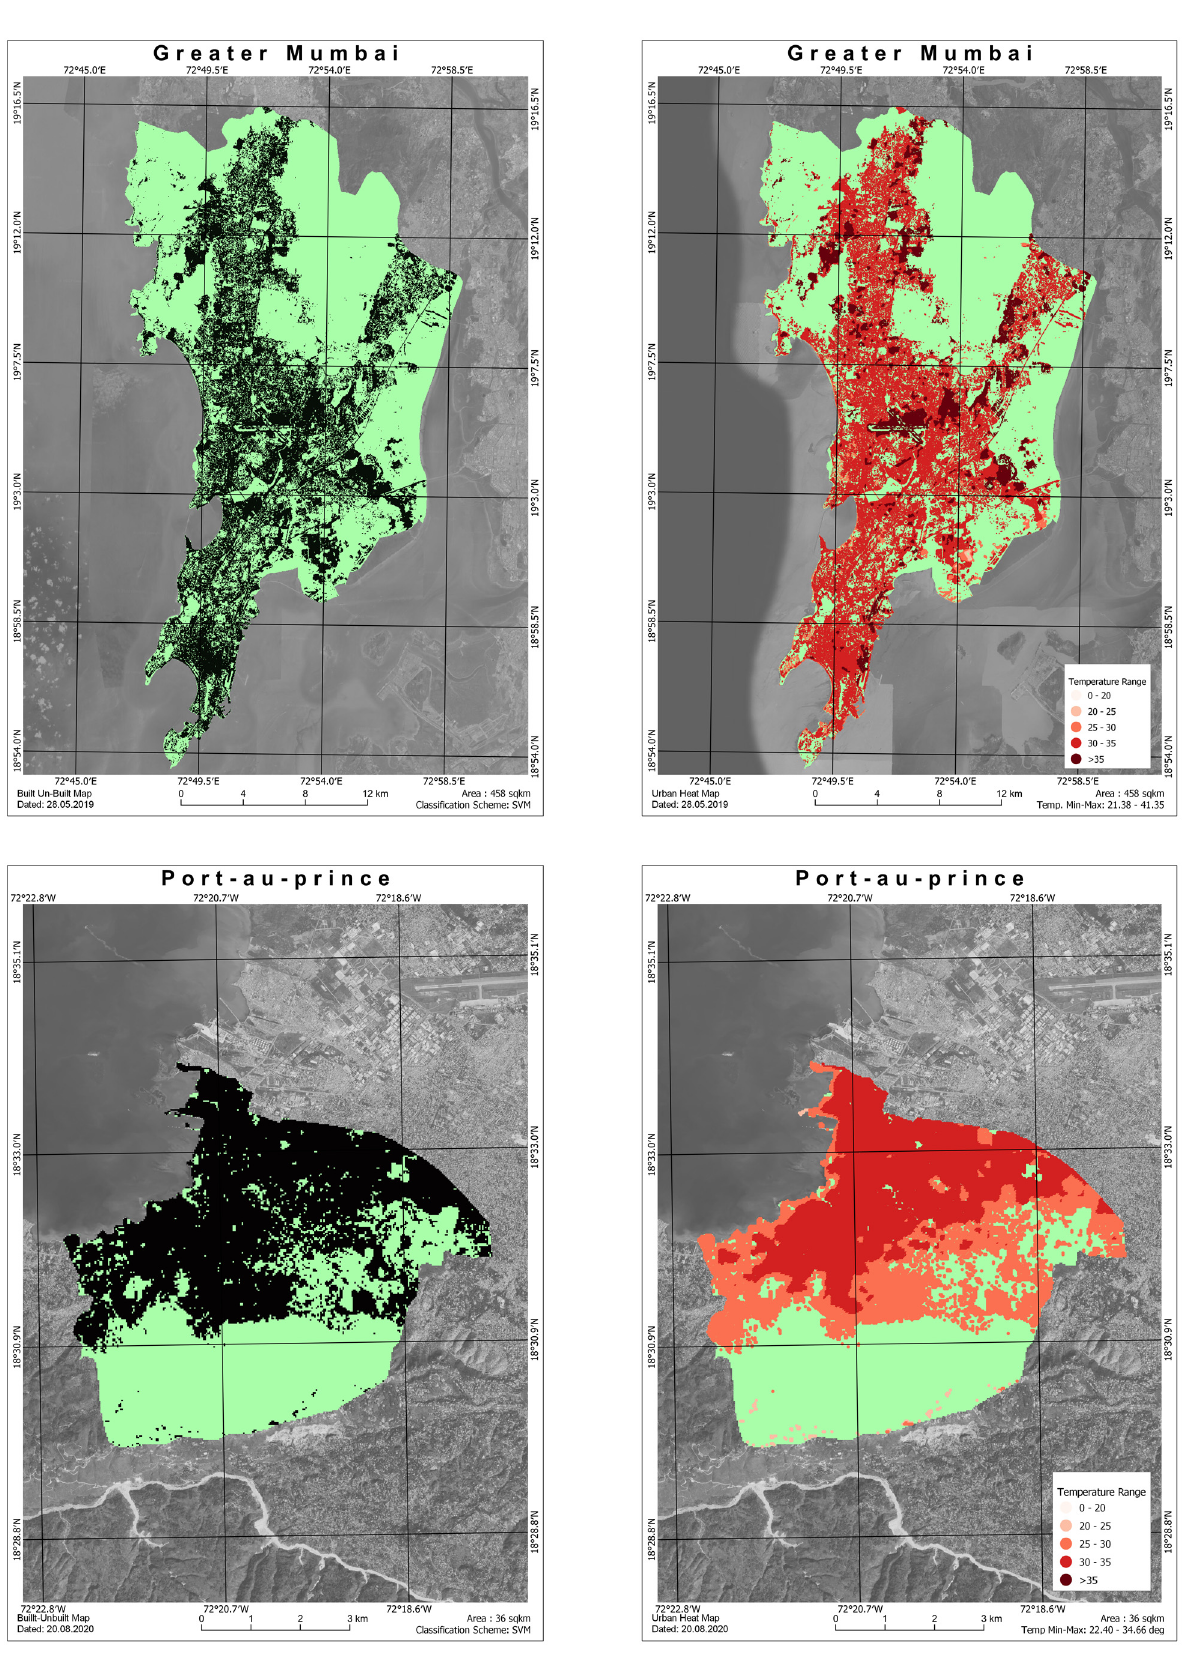
Figure 4. Built (black)/unbuilt (green) map with a corresponding heat map for both a megacity and its respective mid-sized city in mid-latitude region (Mumbai and Port-au-Prince).